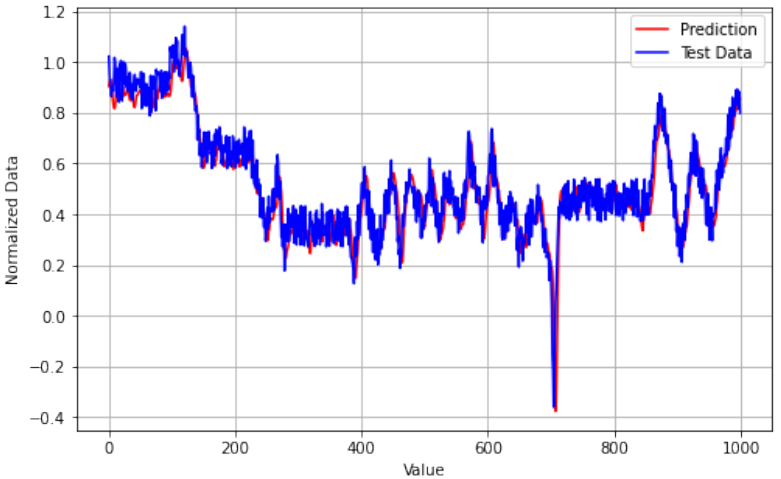
Figure 9. Comparison of the normalized curve for the prediction and test